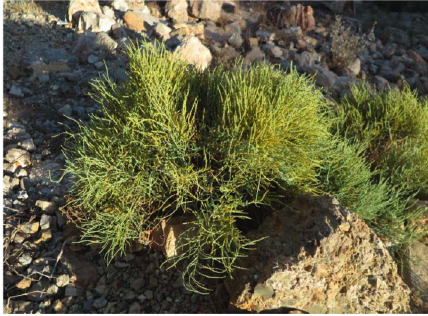
Figure 1: A. syriaca plant